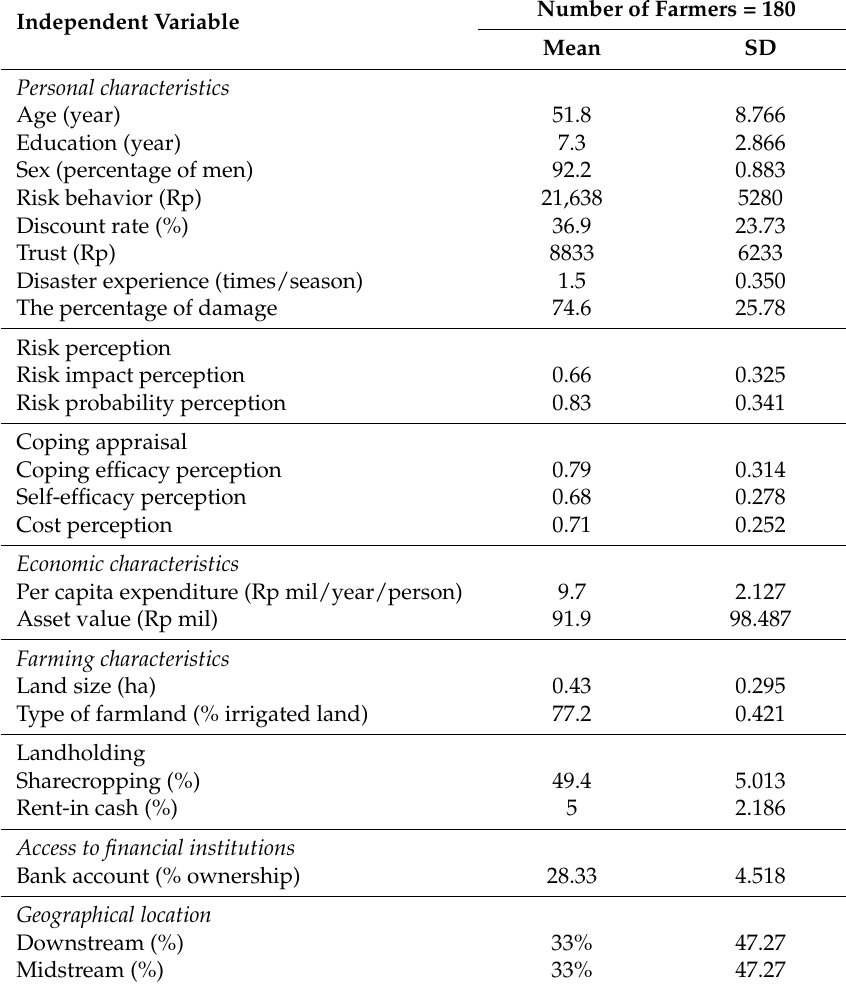
Table 2. Descriptive summary of farmers’